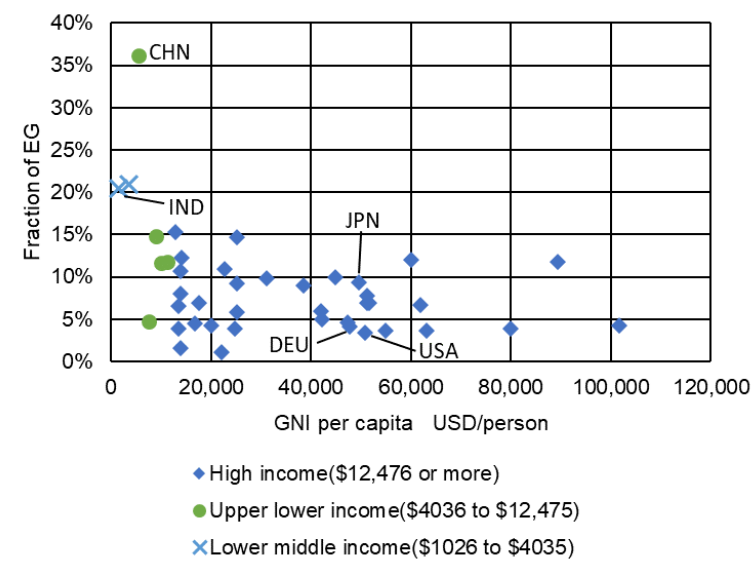
Figure 5. Relationship between GNI per capita and fraction of construction EGs (2011).